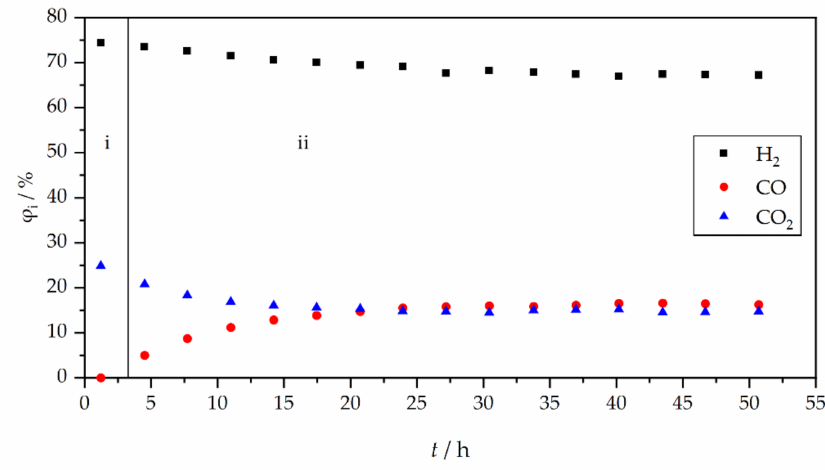
Figure 4. Volume fraction ( ϕ i ) of the gaseous reaction mixture for CO 2 hydrogenation to methanol over the Cu/MgO (38 wt%) catalyst in the semi-continuous tank reactor with external recycle and condensation; operation conditions: 573 K and 5